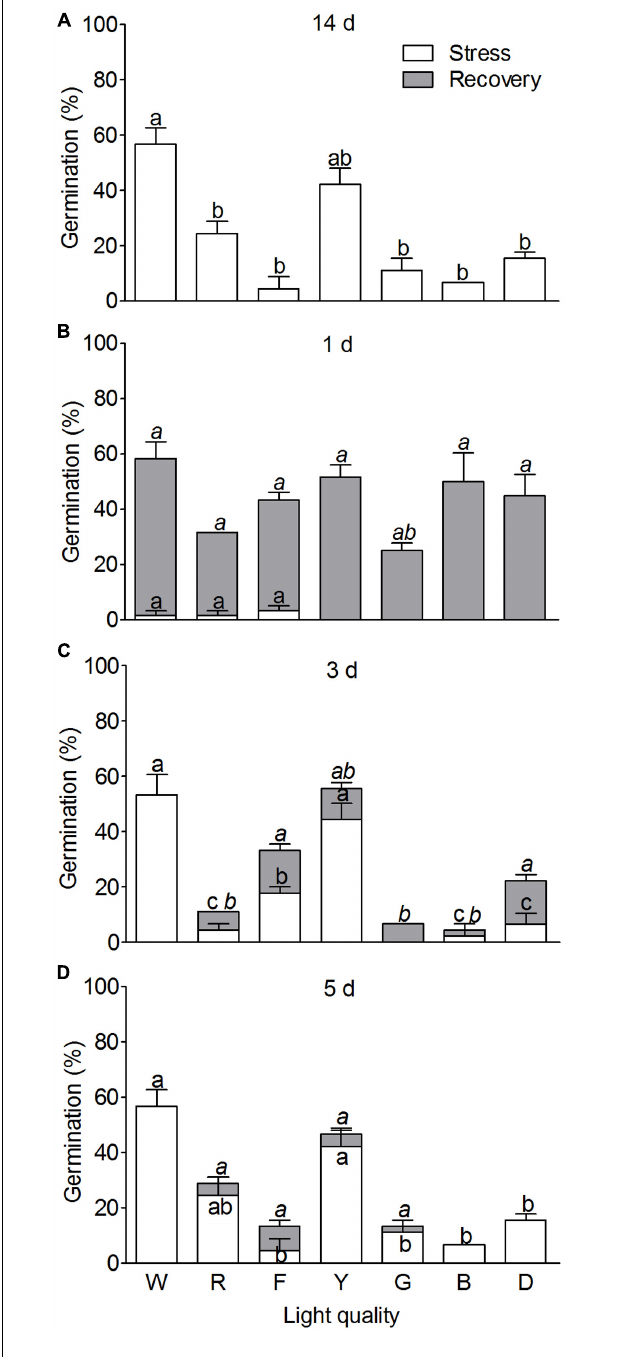
FIGURE 7 | The effect of different wavelength light on seed germination of S. ferganica . Only large seeds were tested in this experiment. NWP, non-winged perianth; WWP, with winged perianth. W, R, F, Y, G, B, D: white, red, far red, yellow, green, black, dark light. (A–D) Different wavelength light treatment for 1, 3, and 5 days, respectively, and their recovery. 1, 3, and 5 d: Different wavelength light treatment for 1, 3, and 5 days, respectively. Stress: Treated with different wavelength light. Recovery: Transferring seeds into white light treatment. Bars with different lowercase letters indicate significant differences ( P < 0.05) according to the Tukey’s test. Values are means ± SE of four replicates.